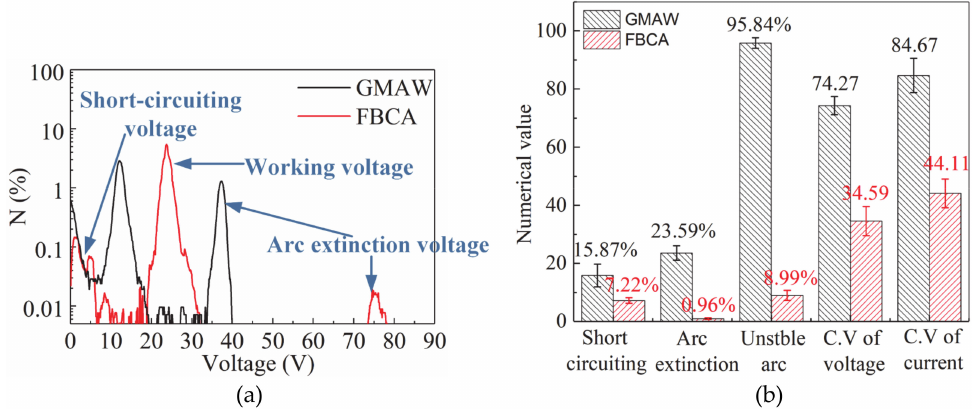
Figure 16. ( a ) Probability distribution of arc voltage and ( b ) the analysis of arc stability in GMAW and FBCA welding